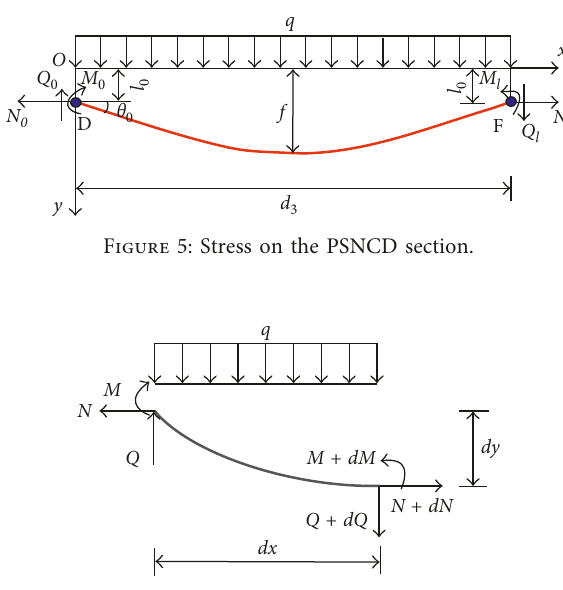
Figure 6: Force analysis of the microunit obtained from section